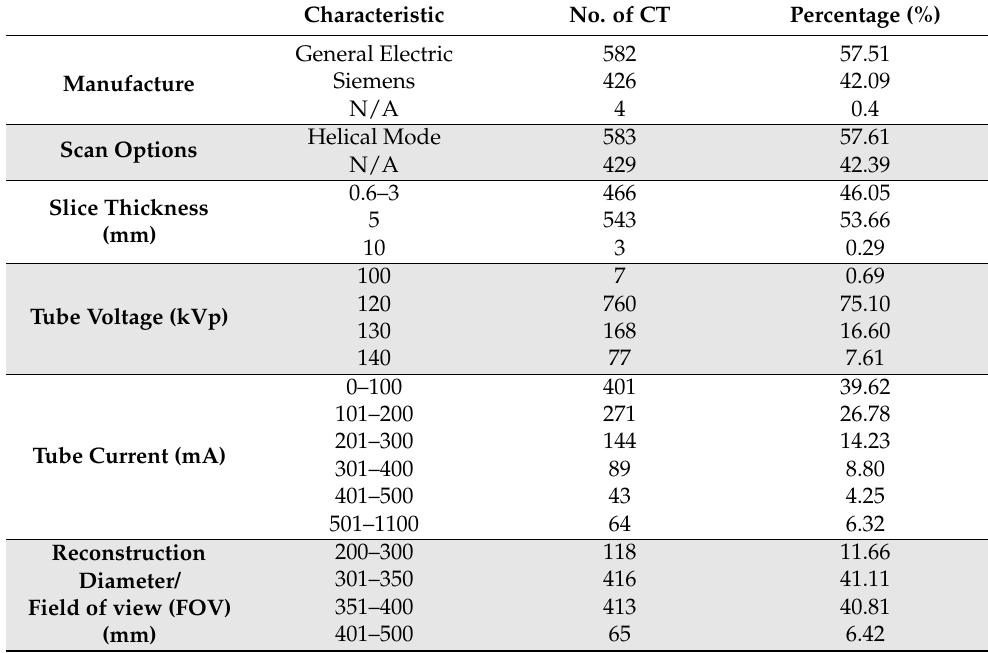
Table 2. Parameters of